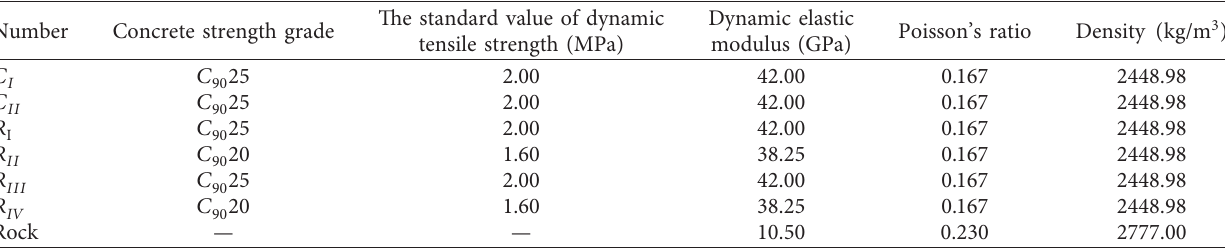
Table 1: Material properties of dam concrete and foundation